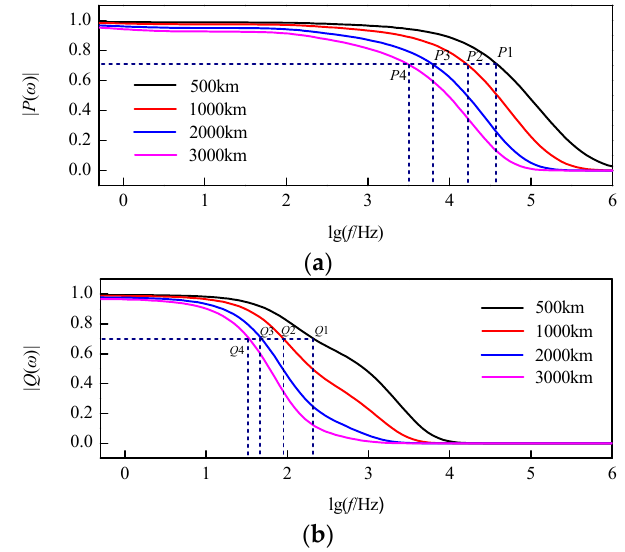
Figure 9. Characteristic curves of modulus traveling-wave (TW) propagation functions: ( a ) 1-mode propagation function; ( b ) 0-mode propagation function.